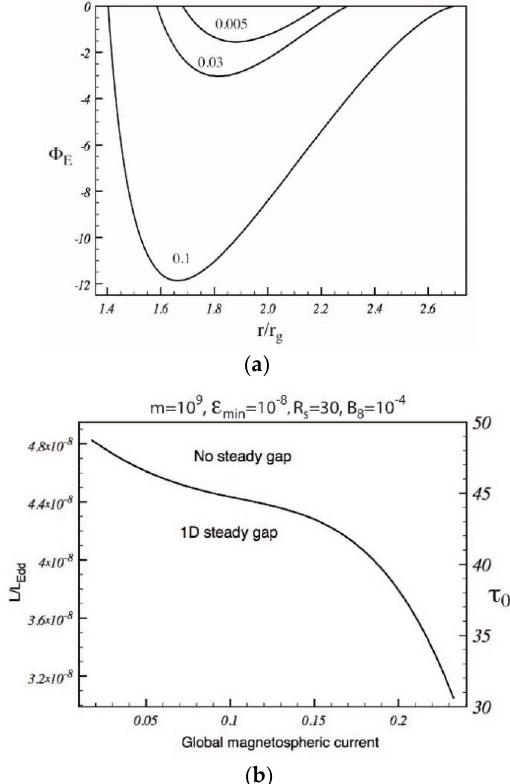
Figure 2. Stationary gap solutions for a billion solar-mass black hole (BH) for a split-monopole magnetic field line. ( a ) Renormalized acceleration electric field as a function of the Boyer–Lindquist radial coordinate. The three solid curves correspond to the solutions obtained for j LS = 0.005, 0.03, and 0.1 (Equation (12)). The peak of the non-corotational electric field, Φ E , is proportional to the square of the created current. ( b ) Maximum Eddington rate (i.e., maximum gap luminosity normalized by the Eddington luminosity) that a stationary gap can attain for a fix magnetospheric current, j LS (abscissa). Adapted with permission from [77].